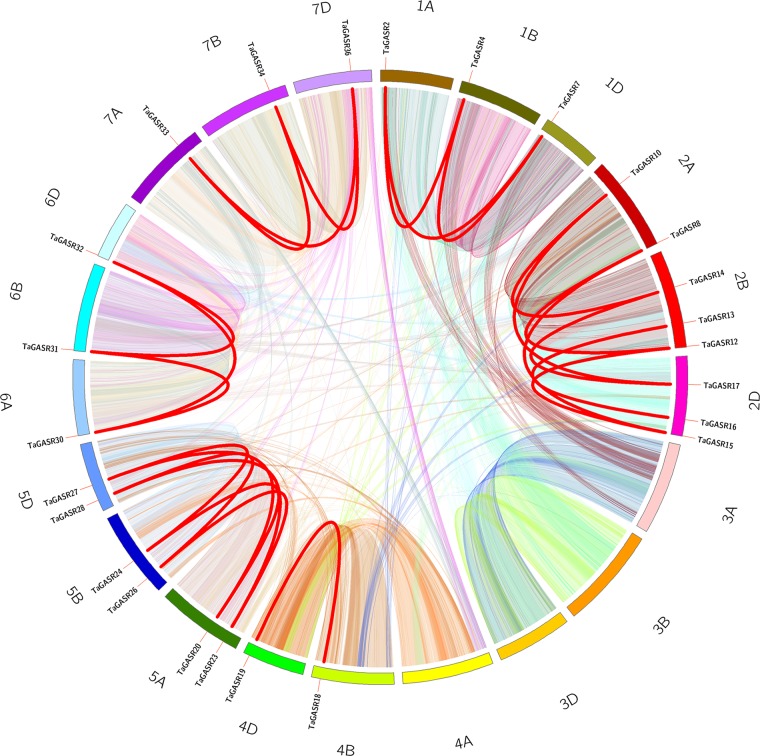
Microsynteny related to TaGASR family in wheat. Wheat chromosomes are shown in different colors. Each chromosome box indicates sequence length in megabases. Different color lines represent syntenic relationships between TaGASR regions, whereas thick red lines represent paralogous TaGASR genes.